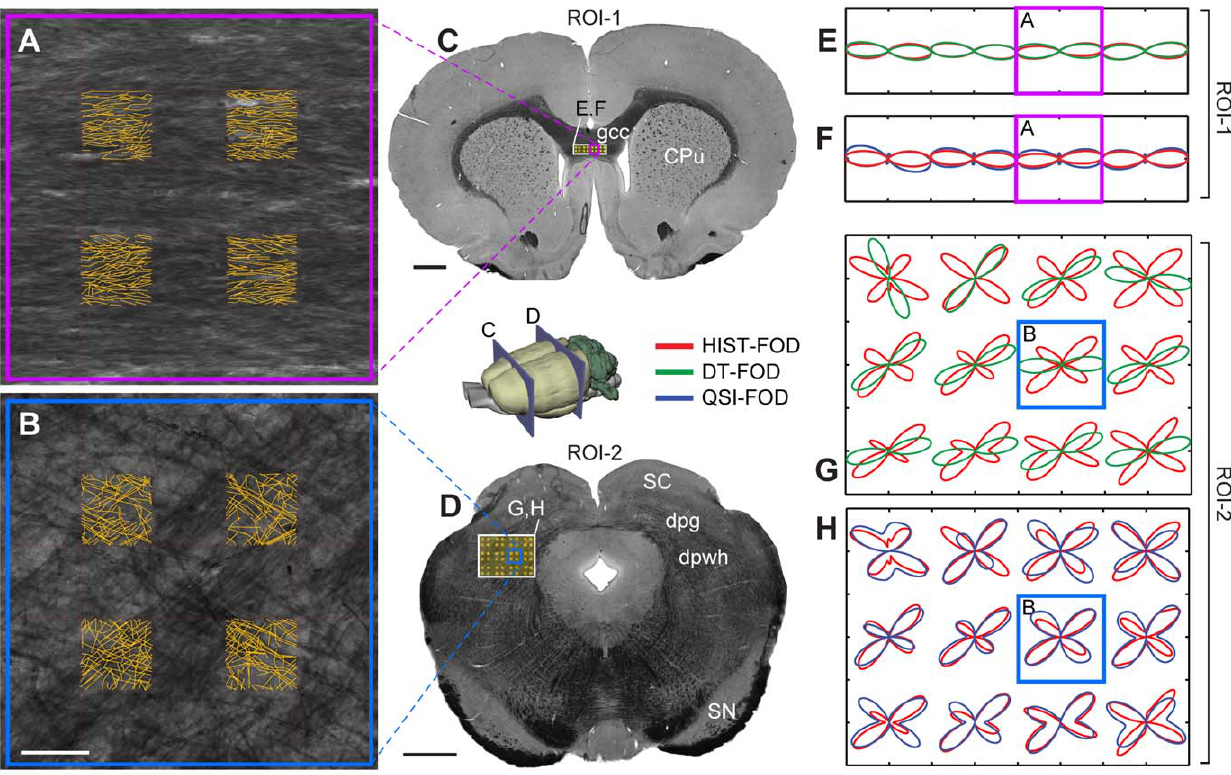
Figure 4. Comparison of FOD estimates against myeloarchitecture. ( A , B ) High resolution images of myeloarchitecture corresponding to one QSI voxel with overlay of 4 sample grids of manually-recorded fiber directions (yellow lines) used in part to compute HIST-FODs (8 total sample grids were used, cf. Fig. 2). Purple and blue frames indicate corresponding voxel locations across panels. ( C , D ) Coronal myelin sections through the genu of the corpus callosum ( C ) and superior colliculus ( D ) (levels indicated on 3D rat brain insert) showing the position of the 1 6 4 voxel ROI-1 and 3 6 4 voxel ROI-2 (white frames, cf. Fig. 1). ( E , F and G , H ) Comparison of QSI-FODs and DT-FODs against corresponding HIST-FODs ( E , F : ROI-1and G , H : ROI-2). gcc, genu of the corpus callosum; dpg, deep gray layer of the superior colliculus; dpwh, deep white layer of the superior colliculus. Scale bar, 50 m m (B) and 1mm ( C , D ).